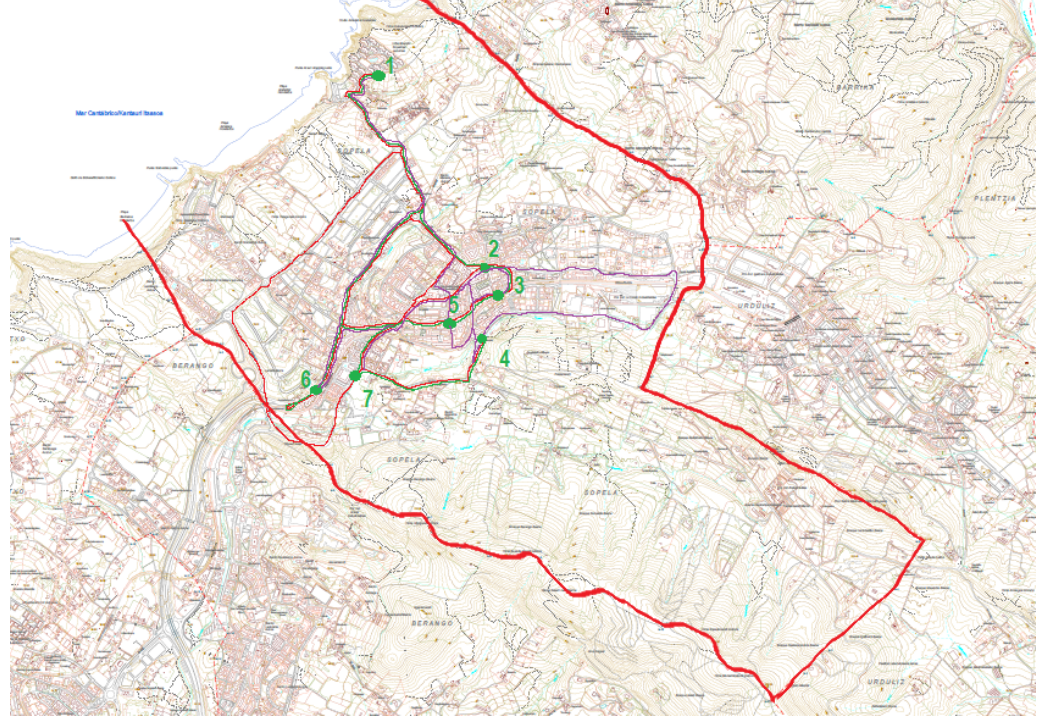
Figure 2. Routes of problem n = 7, longest in red, shortest in green, “average” in